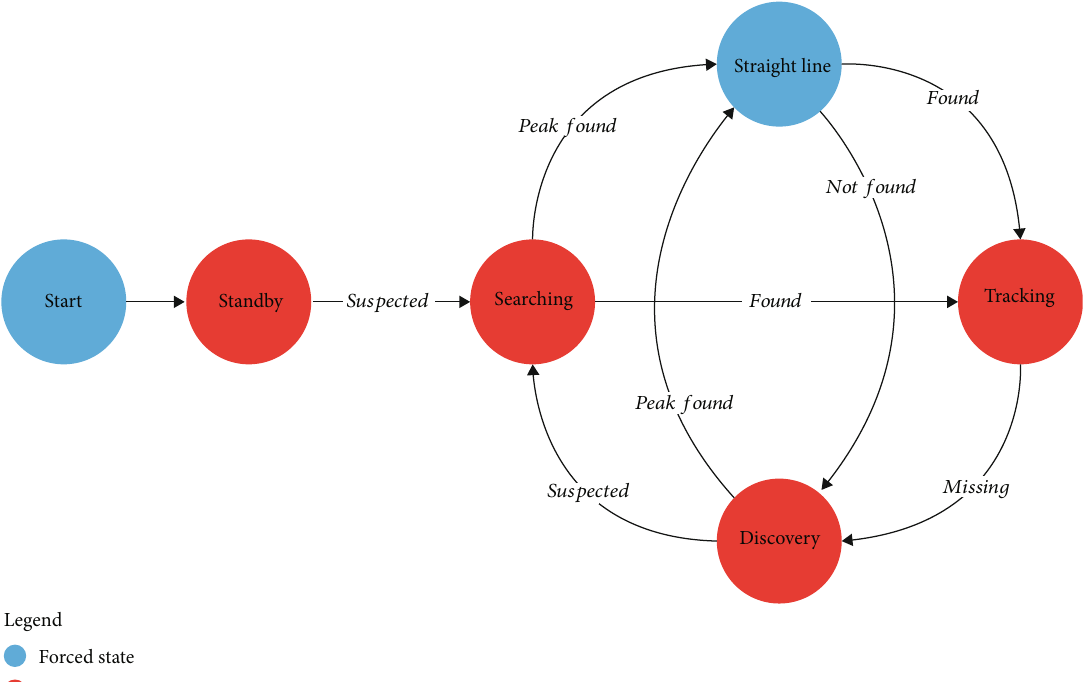
Figure 3: Finite state machine of the searching and tracking process. Calculation of gradient vector is needed only in early time at a searching